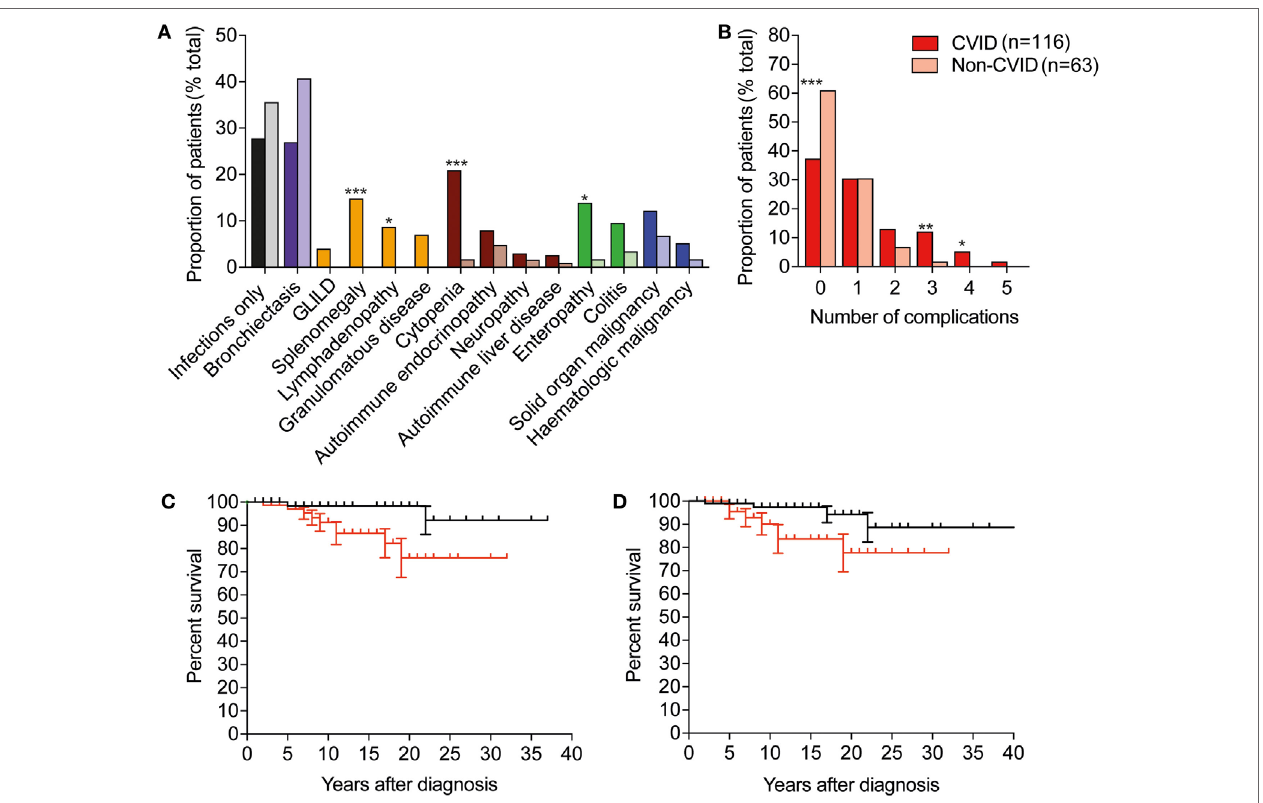
FigUre 2 | CVID is associated with more frequent non-infectious complications than other predominantly antibody deficiencies, and these complications are associated with reduced survival. (a) Histogram depicting frequency of complications in CVID, darker-colored columns, compared with non-CVID cases in lighter-colored columns. Abbreviations: GLILD, granulomatous lymphocytic interstitial lung disease; CVID, common variable immunodeficiency. Purple represents bronchiectasis; yellow represents non-malignant lymphoproliferative complications; brown, autoimmune complications; green, gastrointestinal disease, and blue, malignancies. (Fisher’s exact test: *** p < 0.001; ** p < 0.01; and * p < 0.05). (B) Histogram depicting percentage of CVID and non-CVID patients with 0, 1, or more non-infectious complications of disease. (c) Survival after diagnosis in individuals with immune dysregulation is significantly reduced compared with patients with infections only ( p < 0.05, Mantel–Cox log rank). Black line indicates survival of individuals without features of immune dysregulation, red line indicates survival of individuals with immune dysregulation. (D) Survival after diagnosis in individuals with bronchiectasis is significantly reduced compared with patients with infections only ( p < 0.05, Mantel–Cox log rank). Black line indicates survival of individuals without bronchiectasis, and red indicates survival of individuals with